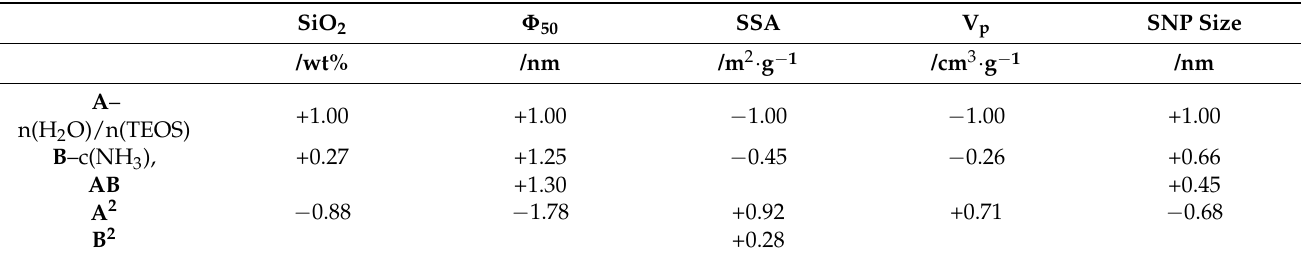
Table 3. Relative effect strength normalized to A = ± 1.00 in terms of coded factors for particle size, SiO 2 content, median pore diameter, specific surface area, pore volume and SNP